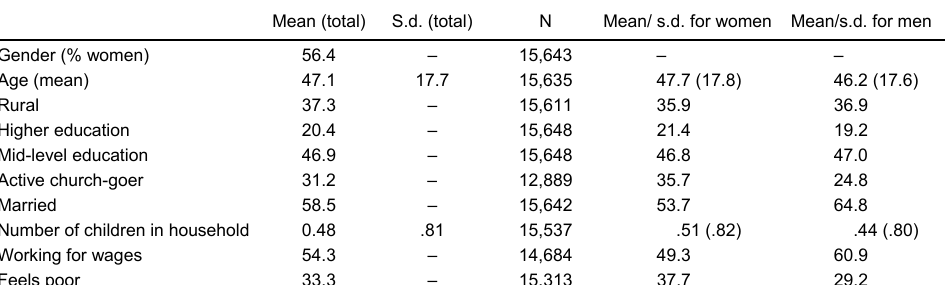
Table 2. Percentages, means, and standard deviations of independent variables in the